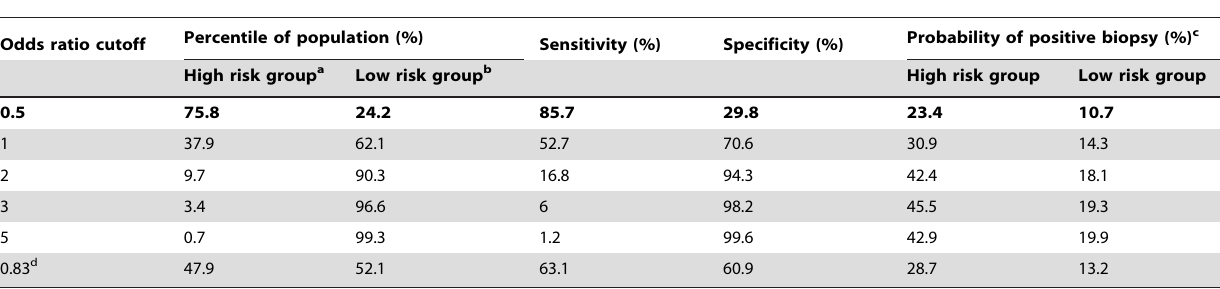
Table 3. Probability of positive prostate biopsy in high and low risk patients grouped by the genetic risk model at various cutoffs.